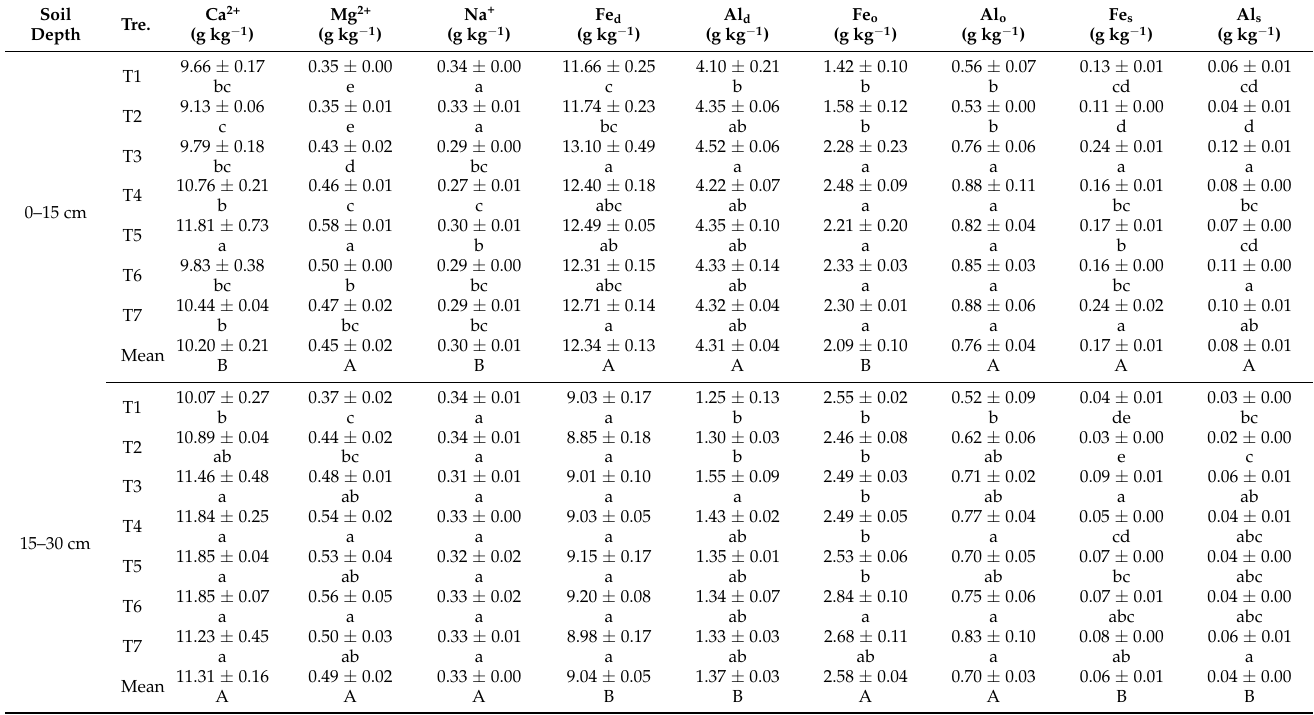
Table 3. Soil exchangeable calcium (Ca 2+ ), magnesium (Mg 2+ ), sodium (Na + ), iron oxide